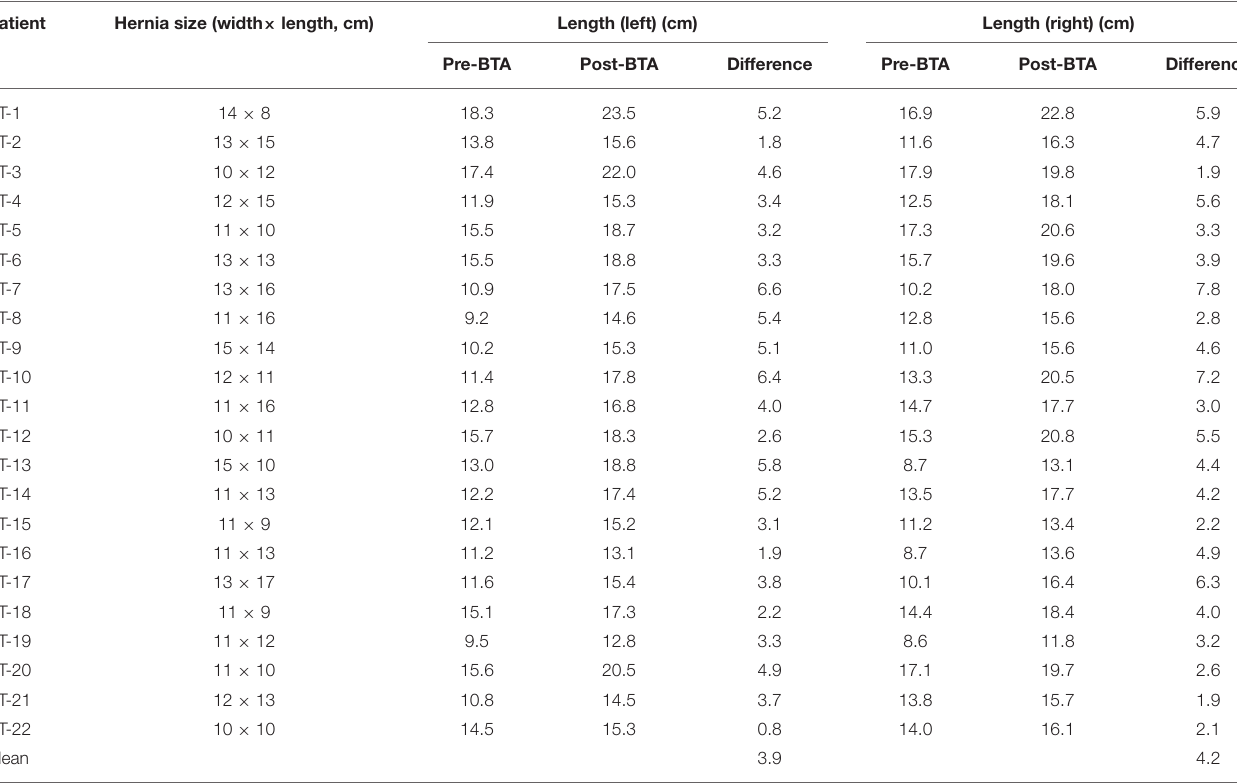
Comparison of lateral abdominal muscle length before and after the preoperative combined use of BTA injection and PPP treatment are show, as measured on CT imaging. All patients except patients 2, 3, and 5 received bilateral BTA injections. PT, patient.